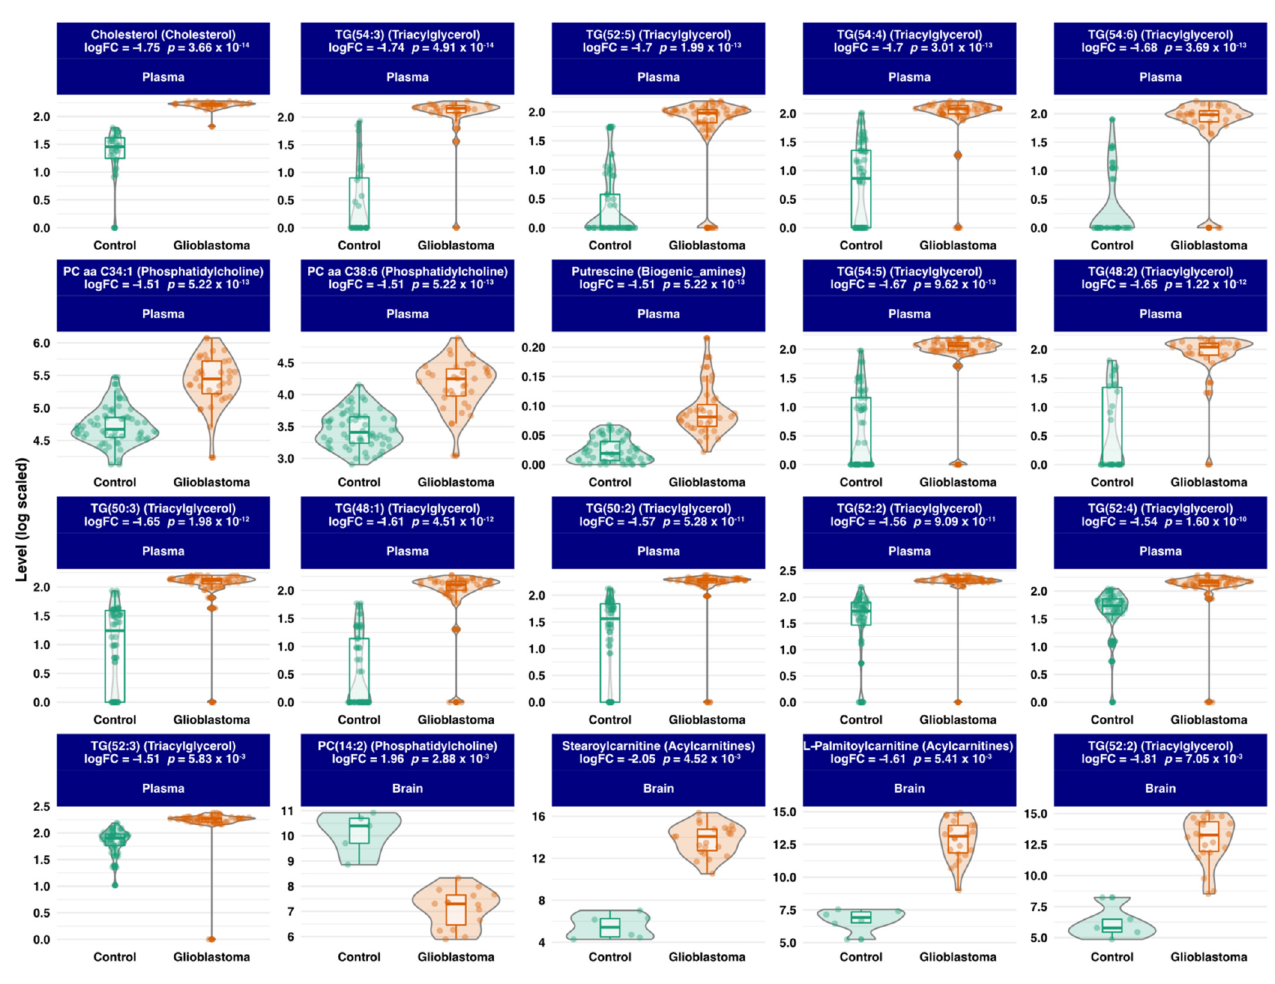
Figure 4. Boxplots of the top (based on adjusted p -values) twenty newly reported metabolites and related biological matrix. Given the rising interest in using circulating free DNA (cfDNA) in oncology [51], we also assessed the associations between the retrieved metabolic profile and cfDNA us- ing Spearman correlations. The analysis yielded 13 positive correlations and 2 negative correlations with a cut-off set at adjusted p -value < 0.05 and abs(Spearman rho) > 0.25. The positively correlated metabolites included Ornithine (Spearman rho = 0.52), Lysine (Spearman rho = 0.49), Phenylalanine (Spearman rho = 0.46), Propionylcarnitine (Spearman rho = 0.45), Carnitine (Spearman rho = 0.45), Hexadecenoylcarnitine (Spearman rho = 0.42), Tetradecadienylcarnitine (Spearman rho = 0.4), Hexenoylcarnitine (Spearman rho = 0.35), Spermine (Spearman rho = 0.3), SM C18:1 (Spearman rho = 0.28), Butenylcarnitine (Spear- man rho = 0.29), SM C16:1 (Spearman rho = 0.29), and Asymmetric dimethylarginine (Spearman rho = 0.27). The negatively correlated metabolites included two biogenic amines Serotonin (Spearman rho = − 0.68) and Methionine sulfoxide (Spearman rho = − 0.29). A network visualization is presented in Figure 6, and full results are presented in Table S17. The full heatmap correlation matrix is presented in Figure